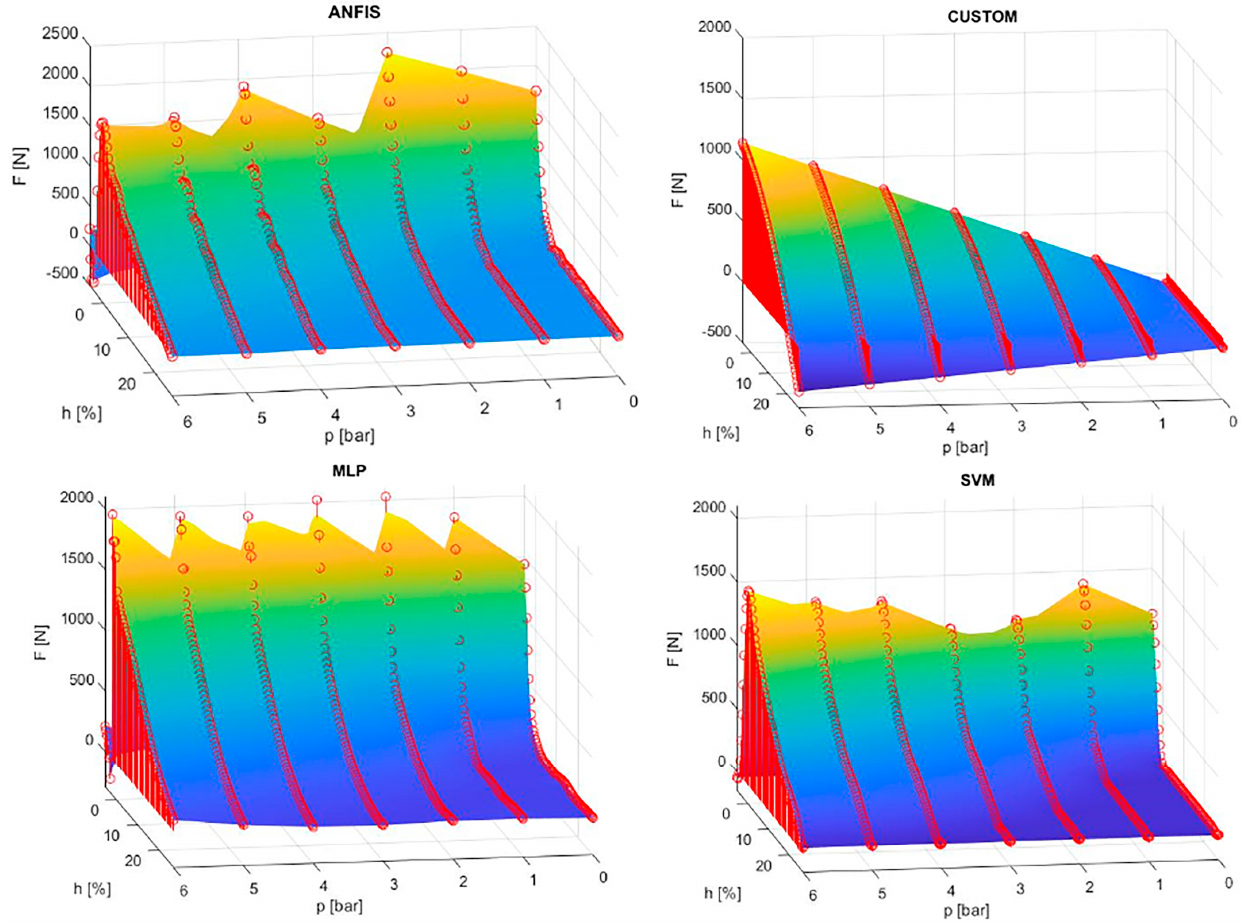
Figure 9. Relations of force, contraction, and pressure approximated by the ANFIS, custom, MLP, and SVM models for the DMSP − 20 muscle.